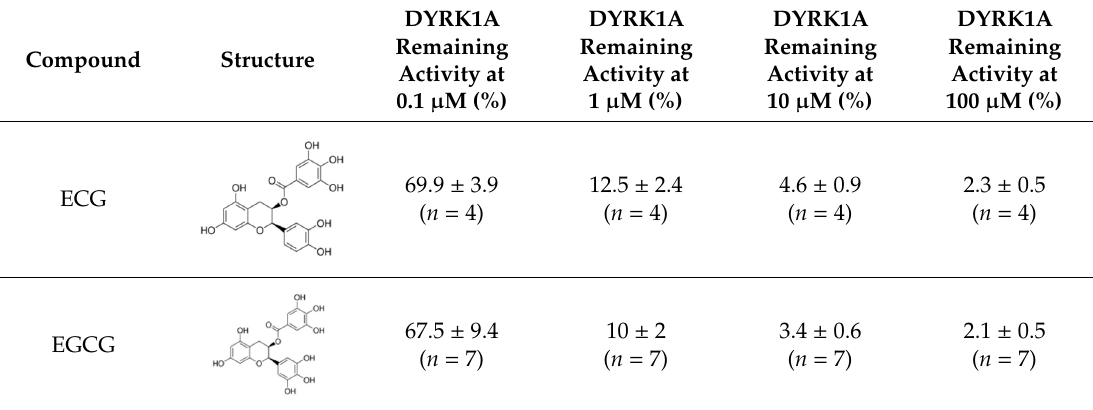
Inhibition of truncated DYRK1A activity (normalized in the absence of inhibitor, expressed as percentage) obtained with different polyphenol concentrations (0.1–100 µM) and 1 mM of ATP and 60 µM of peptide. Table 2. DYRK1A inhibition assay at different concentrations using HPLC-based assays. Compound